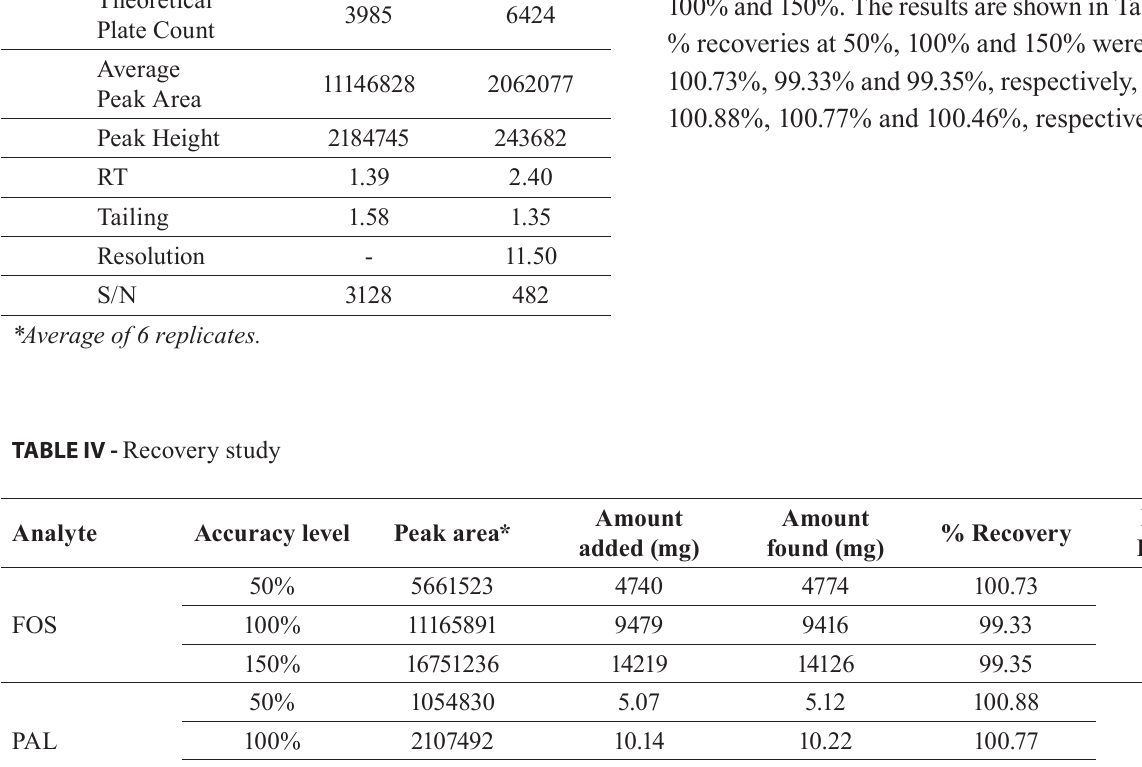
TABLE III - System suitability parameters